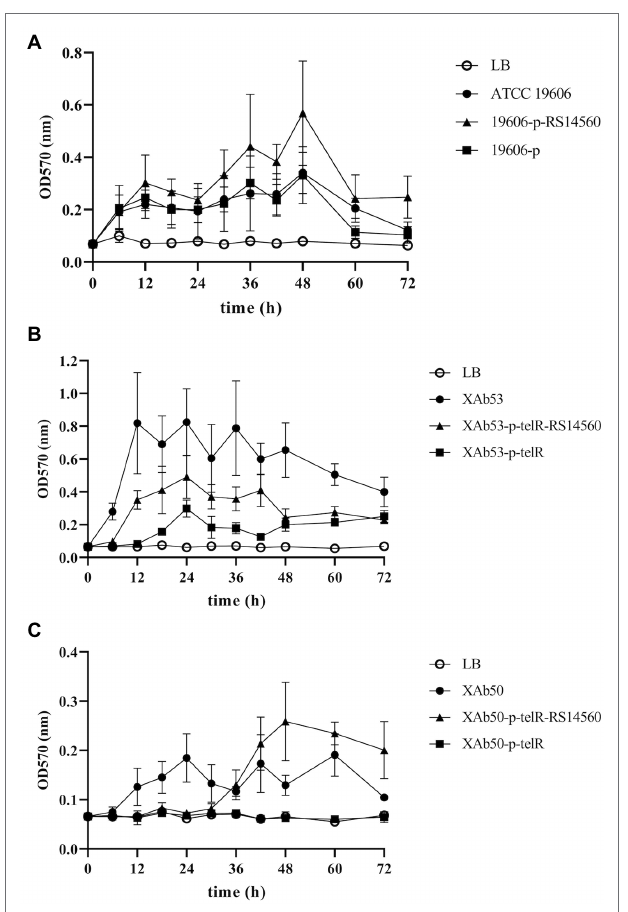
FIGURE 3 | The dynamic changes of biofilm biomass produced by the nine A. baumannii strains at different time points. ATCC 19606, XAb53, and XAb50 are wild-type strains. 19,606-p-RS14560, XAb53-p-telR-RS14560, and XAb50-p-telR-RS14560 are BIT33_RS14560 -overexpressed strains. 19,606- p, XAb53-p-telR, and XAb50-p-telR are empty plasmid control strains. The overexpression of BIT33_RS14560 exhibits enhancing effects, but with various time patterns, on the biofilm formation of strains in the experimental groups. Values are means ± SD of over three independent experiments. (A) Wild-type and recombinant strains of ATCC 19606; (B) Wild-type and recombinant strains of XAb53; and (C) Wild-type and recombinant strains of